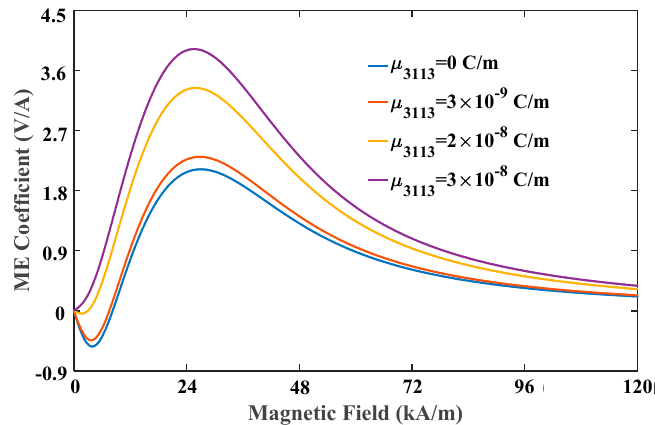
Figure 8. The ME coefficient varied with the applied magnetic field for different flexoelectric coefficients.